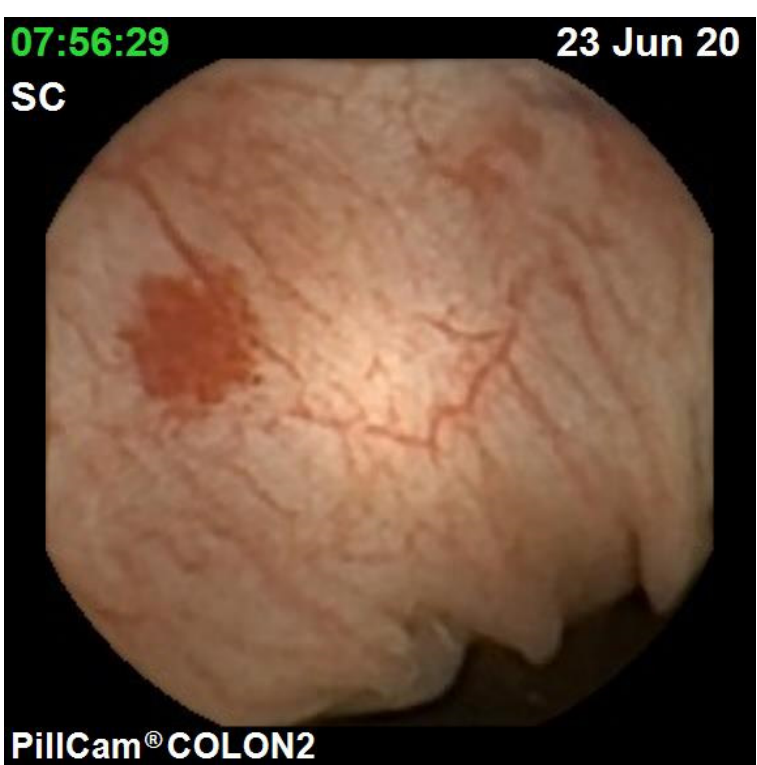
Figure 2. Colonic angiodysplasia.